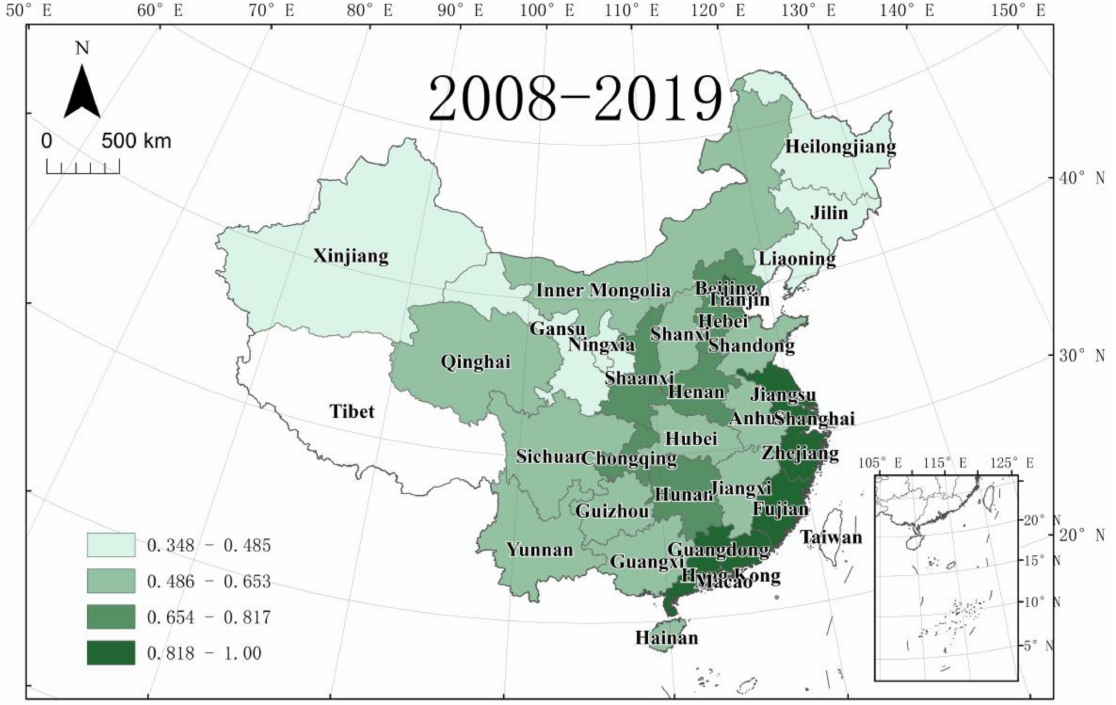
Figure 3. Average EE values in the 30 Chinese provinces